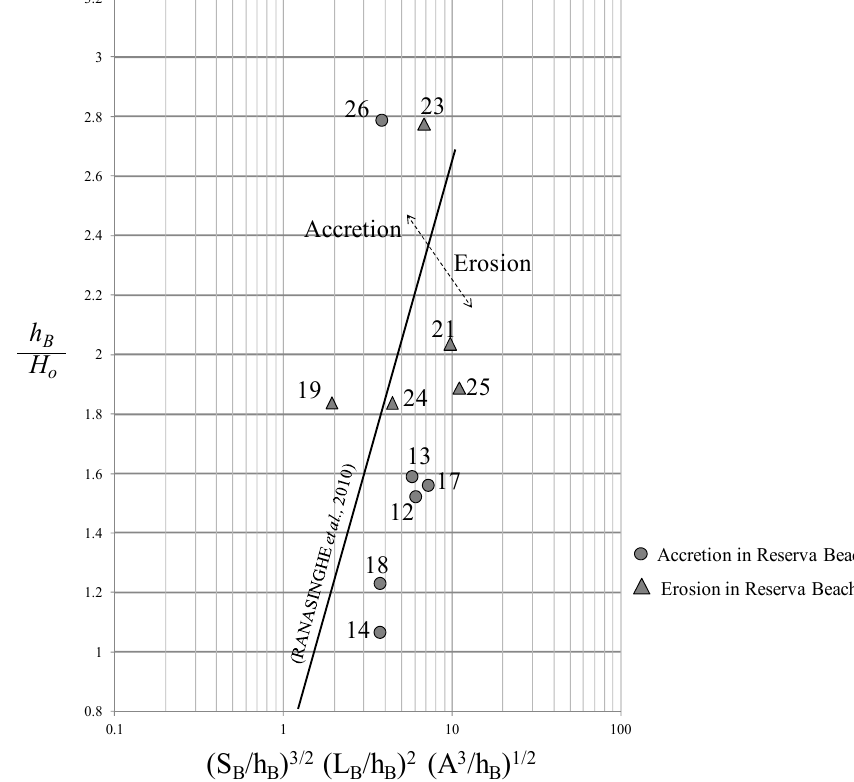
Figure 9. Results of the beach response model to a submerged coastal engineering model proposed by Ranashinghe et al. [22].